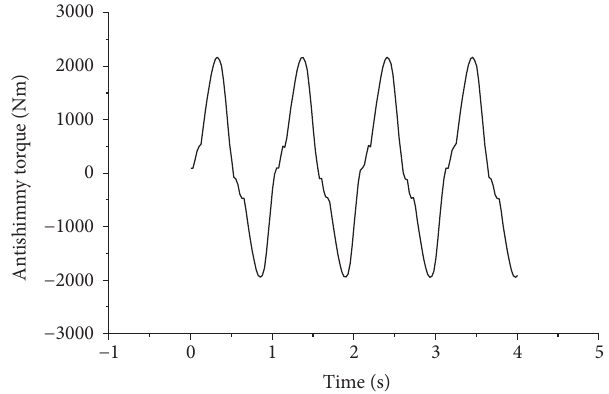
Figure 34: Antishimmy torque produced by antishimmy valves (3) .